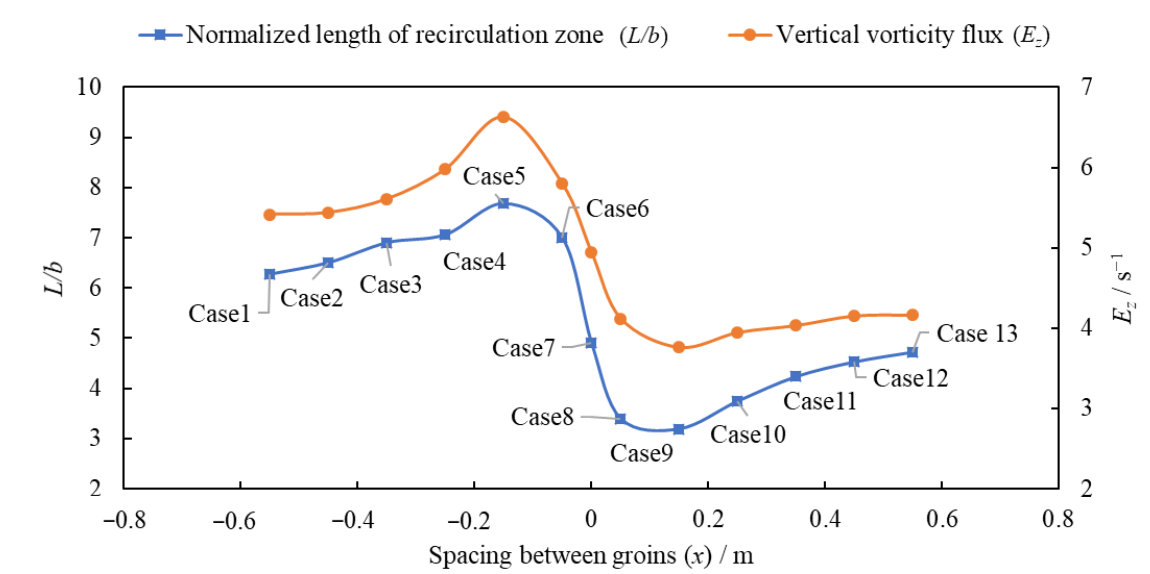
Figure 15. Variation of recirculation zone length behind Groin A with the vertical vorticity flux induced by Groin A for different spacing between groins.